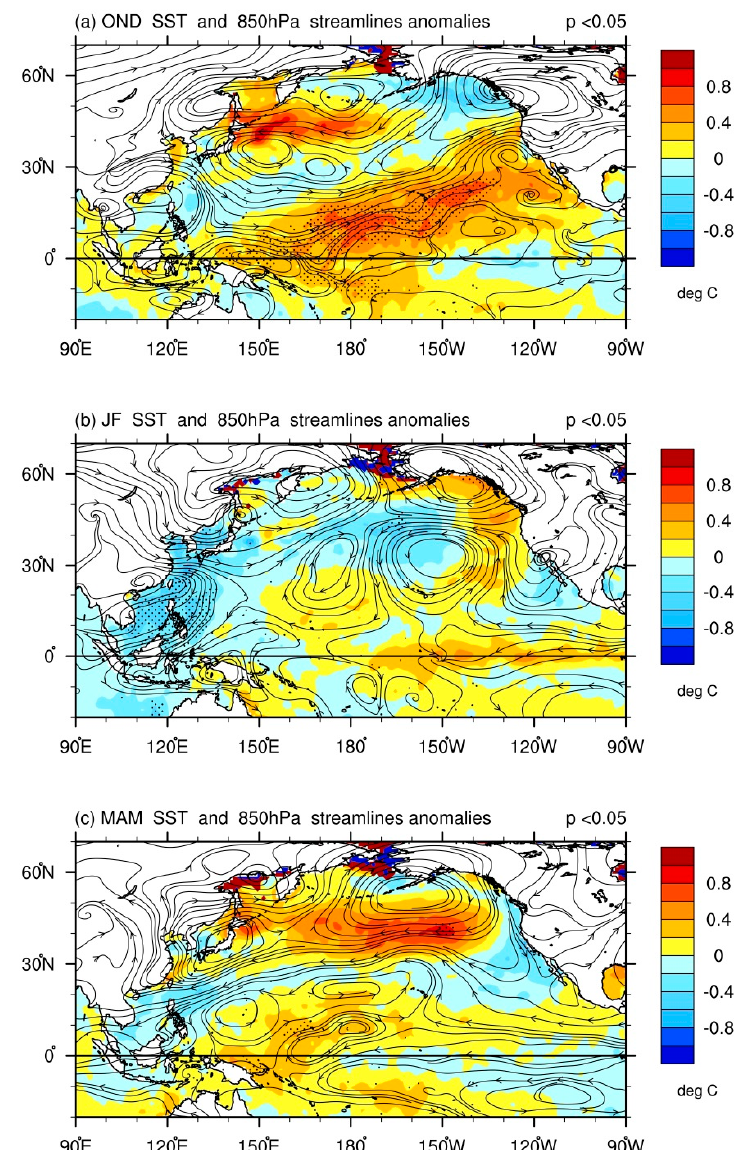
Figure 7. Same as Figure 6, but for anomalous SST (colored shading; unit: °C) and 850 hPa circulations (streamlines) during ( a ) OND, ( b ) JF, and ( c ) MAM. The dots denote areas passing 95% confidence level.